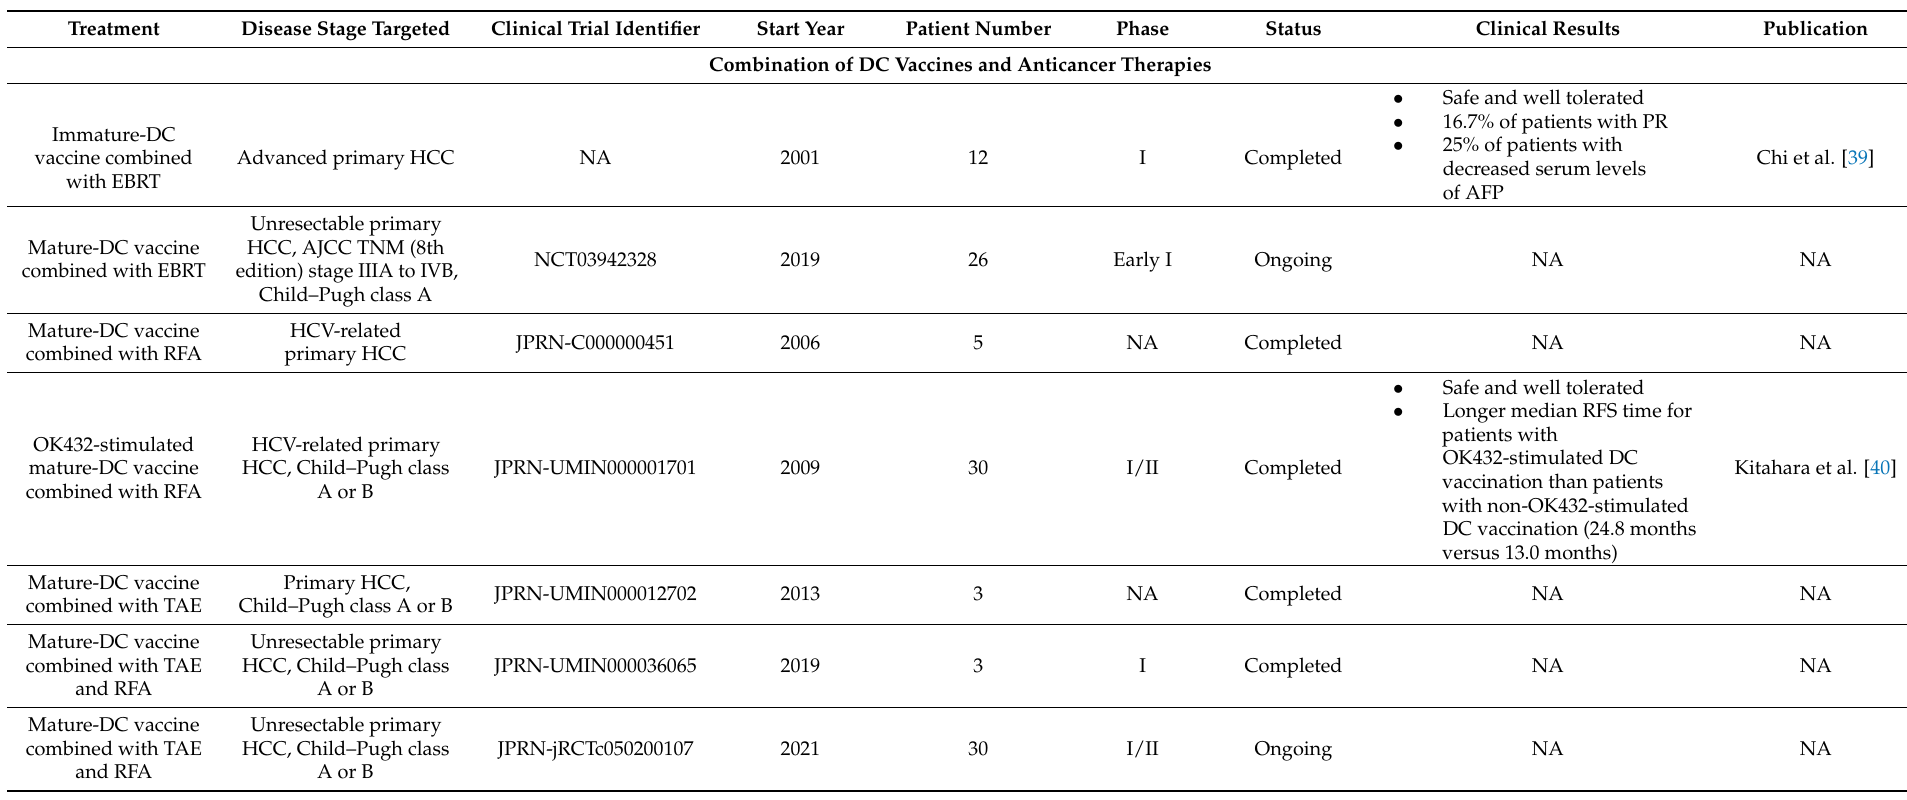
Table 2. Summary of clinical trials regarding DC-vaccine-based combination immunotherapy for treating HCC